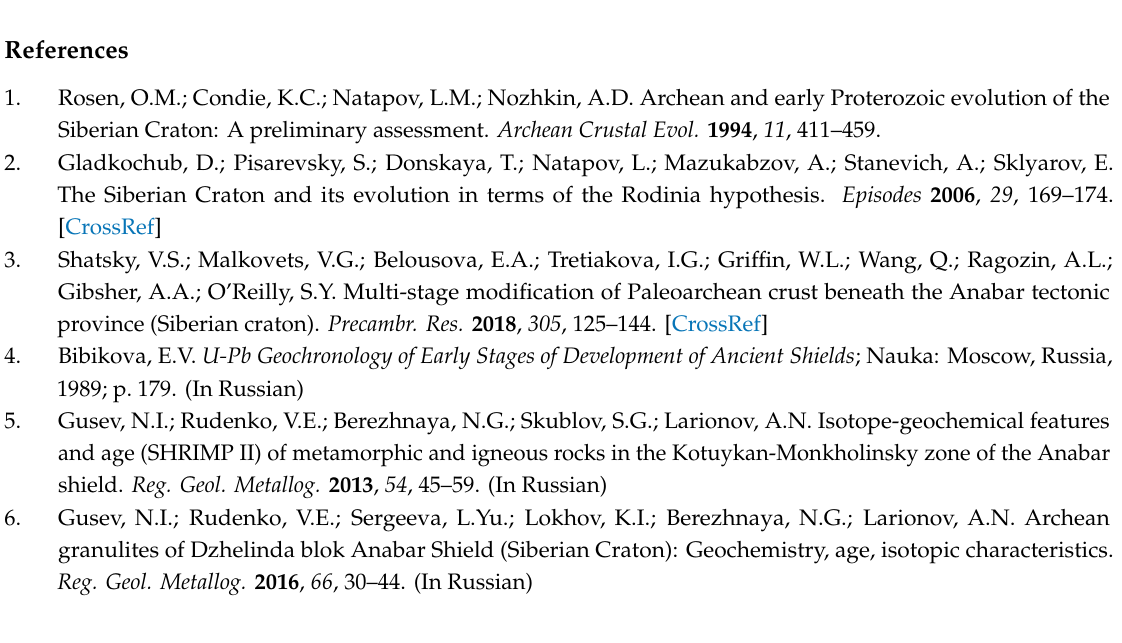
Table S1: Concentrations of major oxides (wt %) and trace elements (ppm) in granulites; Table S2: Results of U-Pb geochronological studies of zircons; Table S3: Trace element concentrations (ppm) and the calculated temperature in zircons from the quartzite (sample 823-1); Table S4: Trace element concentrations (ppm) and the calculated temperature in zircons from the quartzite (sample 523); Table S5: Sm and Nd isotope